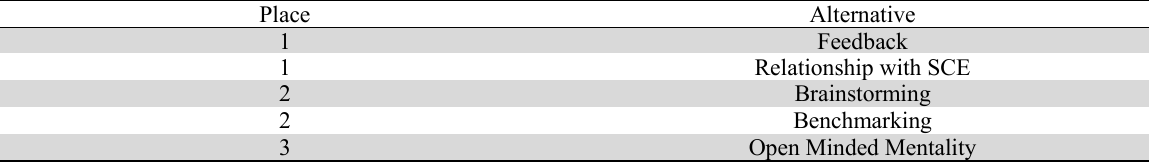
Descend distillation matrix (Final Situation) Place Alternative 1 Feedback 1 Relationship with SCE 2 Brainstorming 2 Benchmarking 3 Open Minded Mentality